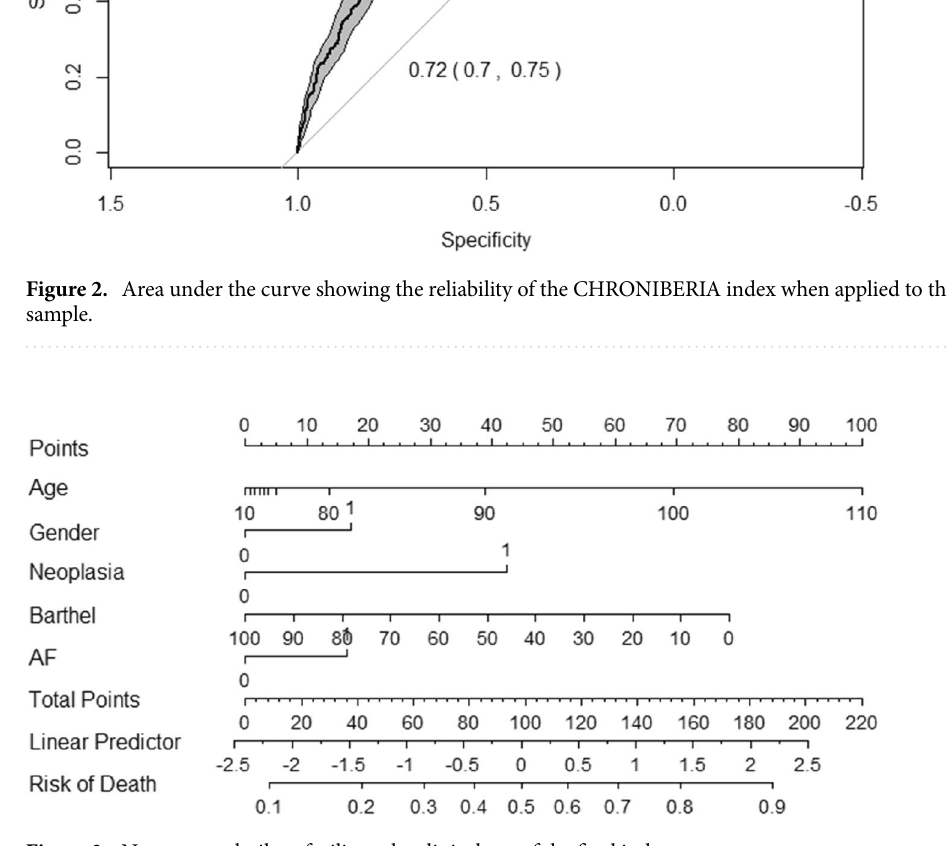
Figure 3. Nomogram, built to facilitate the clinical use of the final